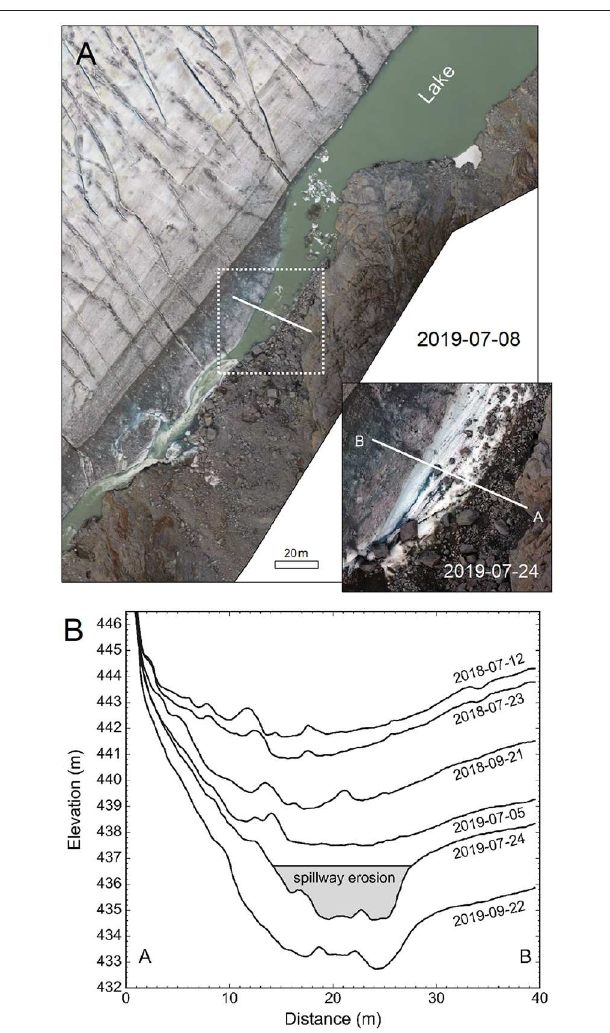
FIGURE 12 | (A) Orthomosaic taken during the 2019 overflow event, showing Suicide Basin’s lake extension and the spillway. The inset map shows the spillway after the overflow event. Transect A–B, along which topography is sampled in (B) , extends across the dam’s lowest portion. The 40 m transect covers an area of solid rock, the ice-cored moraine, the spillway, and relatively clean ice from Mendenhall Glacier. (B) Topography along transect A–B, sampled from six UAV-derived DEMs taken in 2018 and 2019. Spillway erosion during the 2018 overflow event was minimal; during the 2019 event, erosion reached ∼ 2 m along the